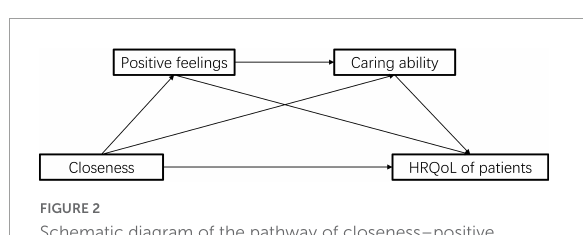
FIGURE2 Schematic diagram of the pathway of closeness–positive feelings–caring ability–patient’s quality of